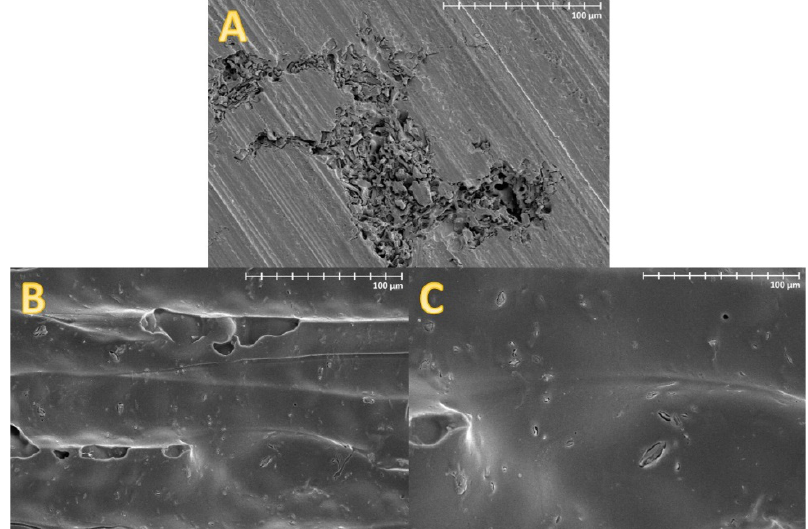
Figure 6. SEM images of acrylic resin with the addition of ( A ) unmodified cellulose, and cellulose modified with ( B ) OTES and ( C ) MPMS, at magnification 1000×.